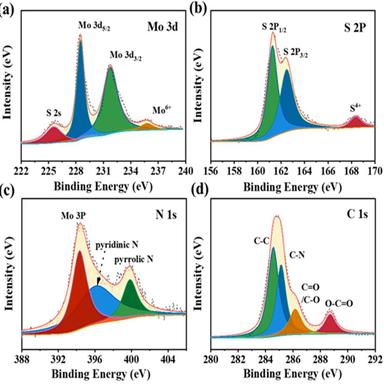
XPS spectra of Mo 3d (a), S 2p (b), N 1 s (c), and C 1 s (d) of MoS2-NT.